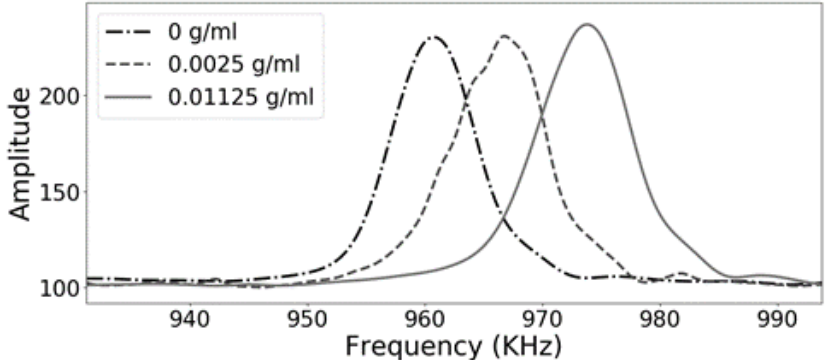
Figure 5. Zoomed-in experimental results of the phononic crystal sensor using distilled water (black dashed and dotted line), and lithium carbonate solutions with a concentration of 0.01125 g/mL (gray solid line) and 0.0025 g/mL (gray dashed line).